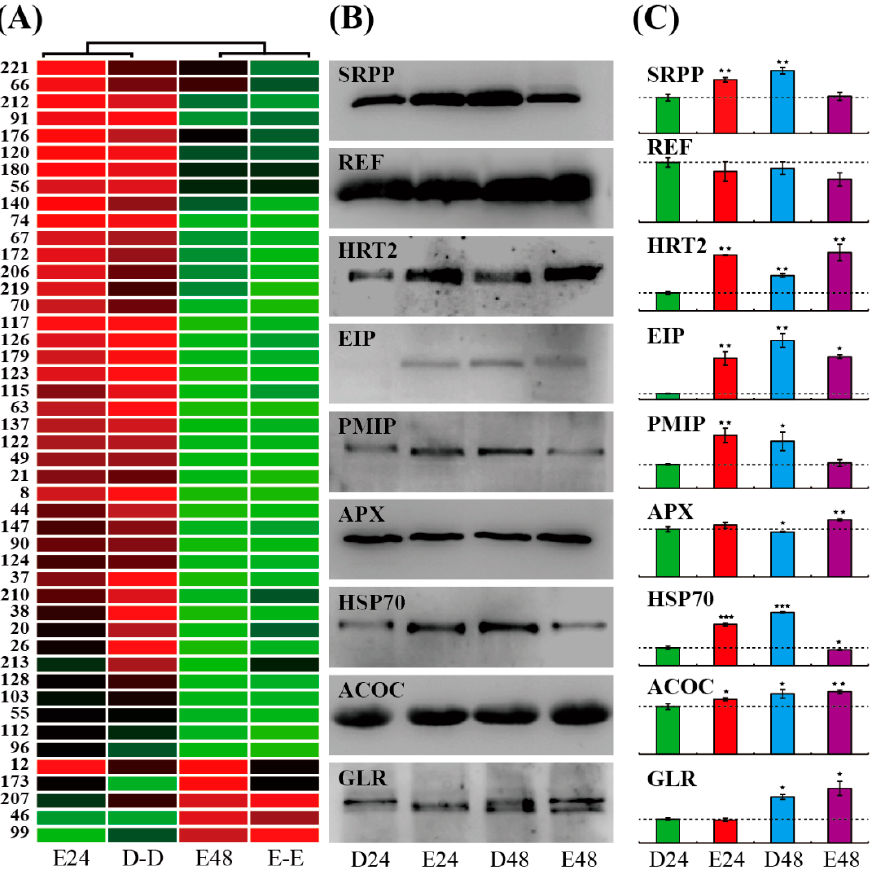
Figure 5. Accumulation patterns of the typical ethylene-responsive proteins in SRPs. The 4 columns represent the 46 sharply changed proteins under the E24 / D24, D48 / D24, E48 / D48, and E48 / E24 treatments (marked as E24, D-D, E48, and E-E). The up- or down-accumulated proteins are indicated in red or green color, respectively. The protein number from iTRAQ (I-) is indicated on left side ( A ). Western blotting showed the general protein accumulation patterns ( B ). The dotted line represents the changed ratio value of 1.0 ( C ). * p , 0.05, ** p , 0.01, and *** p , 0.001.